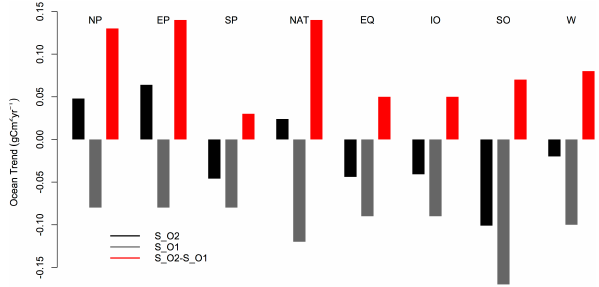
Figure 10. Regional ocean flux trends from 1990 through to 2004 for the standard case, i.e. variable climate and increasing CO 2 (sim- ulation S_O2), and for the constant climate case (simulation S_O1), and their difference (S_O2–S_O1). Ocean regions comprise North Pacific (NP), equatorial Pacific (EP), South Pacific (SP), North At- lantic (NAT), equatorial/South Atlantic (EQ), Indian Ocean (IO), and Southern Ocean (SO), and world oceans